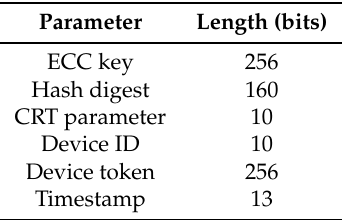
Table 3. The length of parameters used in our proposed scheme.